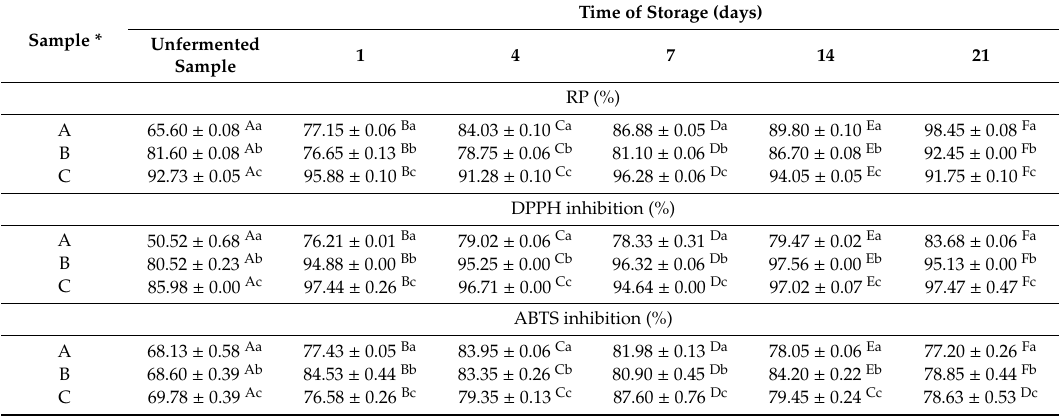
Table 6. Reducing power (RP), DDPH, and ABTS radical scavenging ability of fermented beverages and unfermented (control)